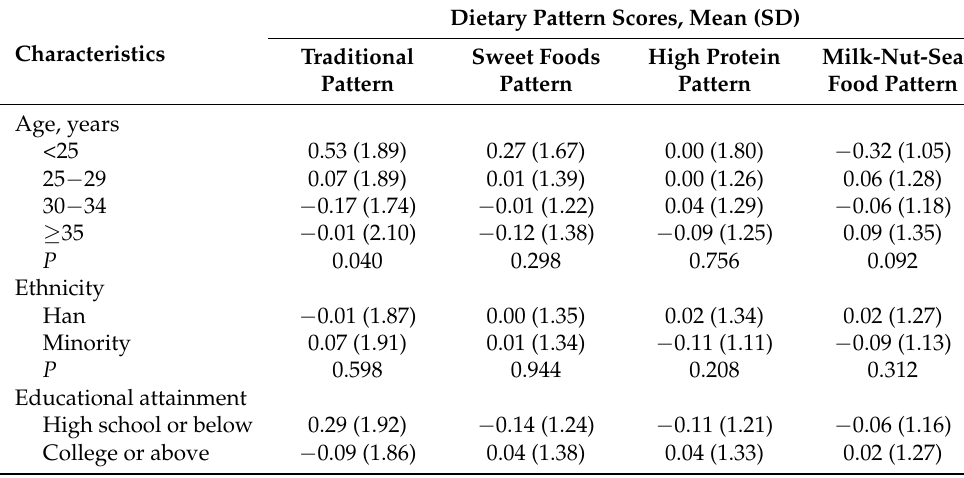
Table 3. Dietary pattern scores according to participant characteristics ( n =